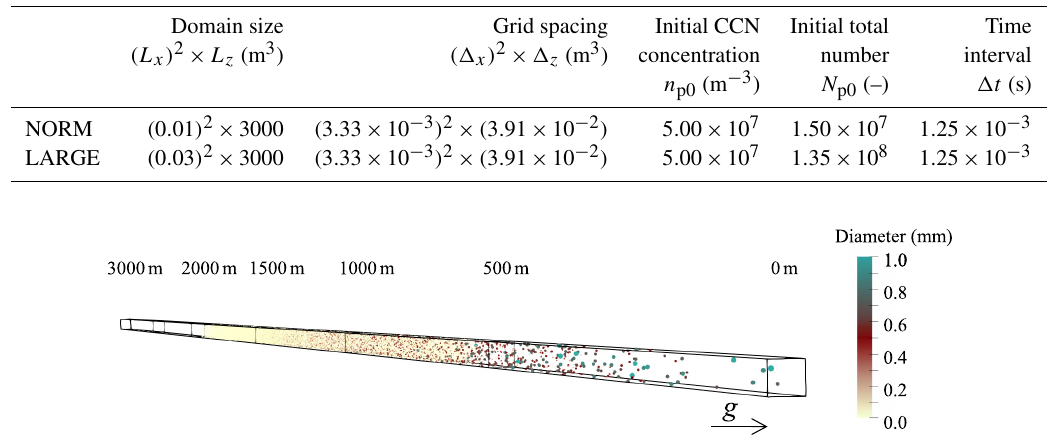
Figure 1. Quasi-one-dimensional domain for the direct Lagrangian tracking simulation. Liquid droplets at t = 1300s for a NORM simulation are drawn, while the CCN particles (dry aerosols) are not. The color of each droplet denotes its diameter. For more information, see the Supplement.